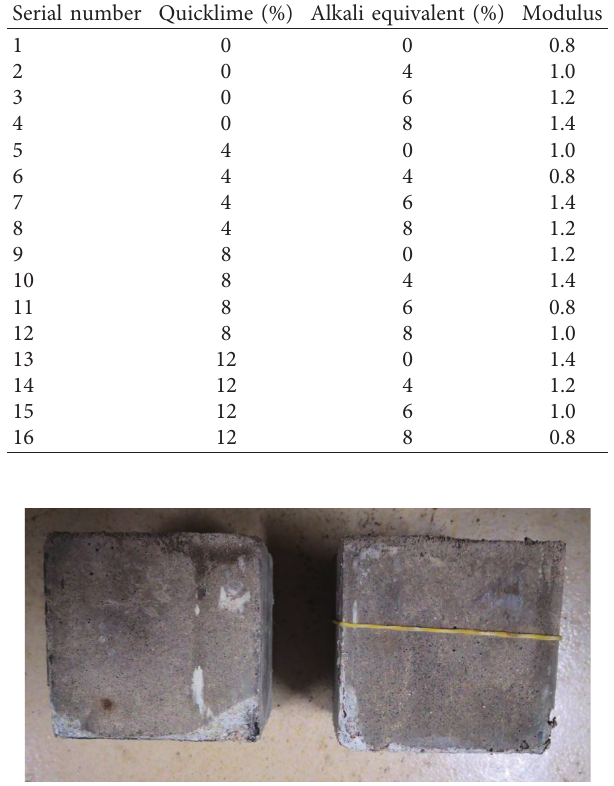
Figure 3: The 11th group of CUTB after 14 d